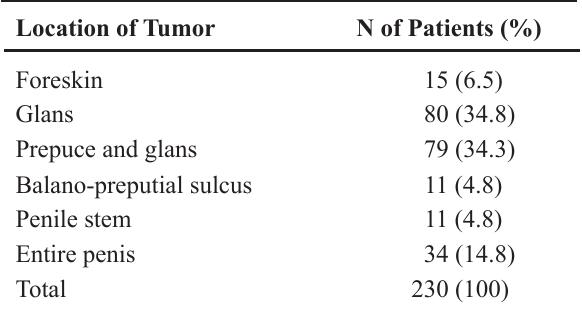
Table 2 – Initial location of penile lesions in 230 pa-